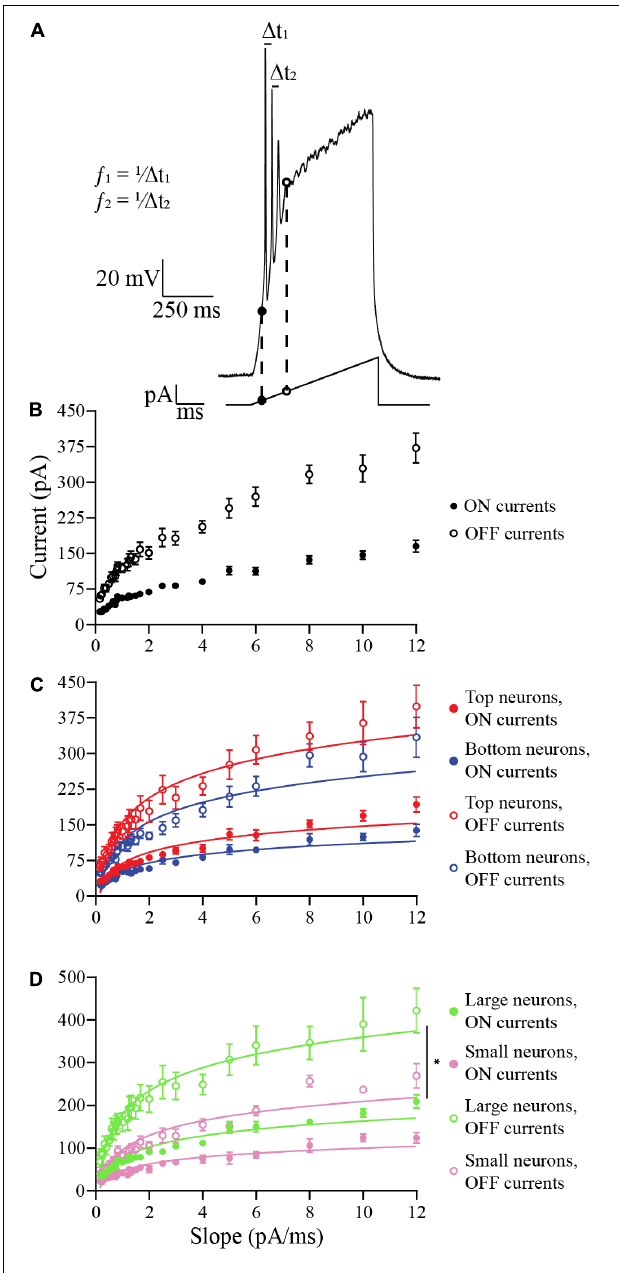
FIGURE 6 | Analysis of the effects of ramp slopes (in pA/ms) on the ON and OFF currents of OB DA neurons. (A) Example of a ramp protocol (bottom) and a resulting voltage trace (top). The traces and their corresponding ramps were used to determine the ON (black circles) and OFF (white circles) currents. This figure also shows an example of how spike frequencies are derived from traces of ramp protocols (data shown in Figure 7 ). Of the 42 ramps used, some ramps had identical slopes (e.g., the slope of 2 pA/ms can include ramps of 200 pA for 50 ms, 400 pA for 100 ms, etc.). For different ramp protocols with the same slopes, the ON and OFF currents and the spike frequencies and number of action potentials in the next figure were averaged. (B) Averaged ON and OFF current responses to ramp slopes (derived from 19 neurons). Increasing the slope increases the ON and OFF current of all neurons, but the largest effect is on the OFF current. This also indicates a